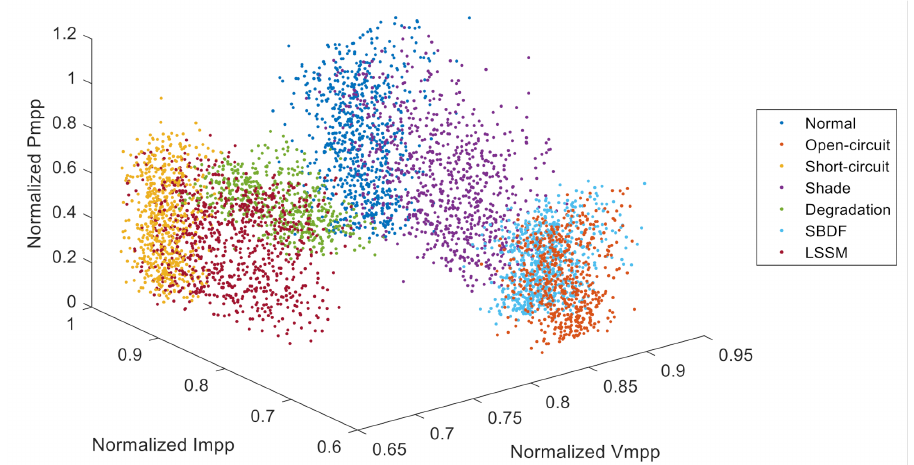
Figure 13. The normalized noise data under normal and fault conditions.